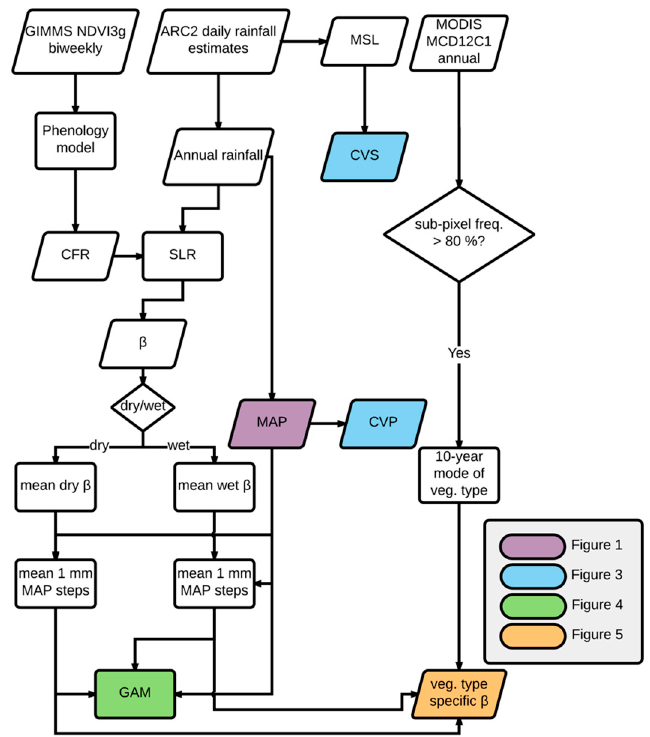
Figure 2. Flowchart of the data processing and analysis. MSL refers to mean season length, CVS is the coefficient of variation of season length, MAP represents mean annual precipitation, CFR refers to cyclic fraction, SLR abbreviates shifting linear regression models, β represents vegetation functional response to rainfall, dry/wet refer to below and above average rainfall conditions, respectively, GAM represents generalized additive models. The colouring scheme refers to the figure in which the respective analysis step is presented.